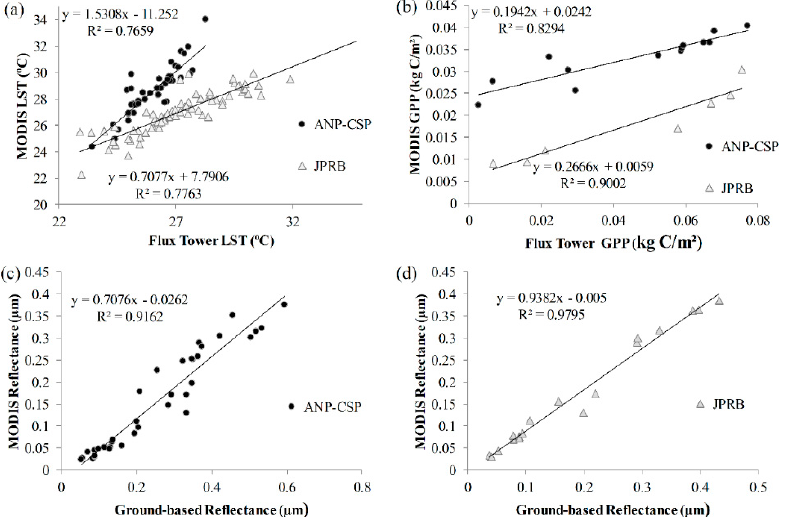
Figure 3. Validation using Large-Scale Biosphere-Atmosphere data for: ( a ) Land-Surface Temperature (LST) from the Moderate Resolution Imaging Spectroradiometer (MODIS) data, ( b ) Gross Primary Productivity (GPP) from the MODIS data, ( c ) MODIS reflectance in the Araguaia National Park and Cantão State Park (ANP-CSP), and ( d ) Ji-Paraná River Basin (JPRB).